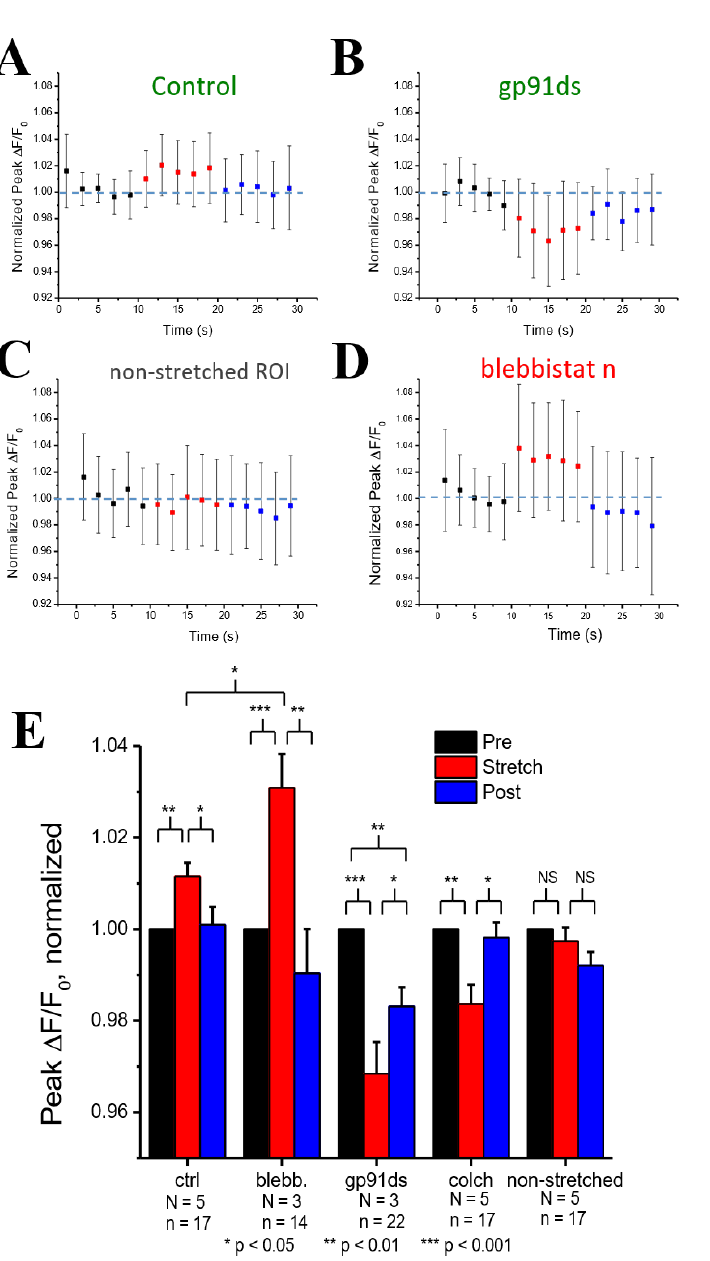
Figure 3. Experimental results for the normalized peak ∆ F/F0 for the concentration of Ca 2+ in the myoplasm ([Ca 2+ ] i ) with 0.5 Hz stimulus when the cardiomyocyte is at rest (black), stretched (red) and released after the stretch (blue) A . Under control condition. B . When blebbistatin is used which inhibits the actin – myosin bridge formation. C . When gp91ds is used which inhibits NOX2 from producing stretch-dependent ROS. D . In a non-stretched region of control myocytes, and E . the calculated average of peak ([Ca 2+ ] i ) under each subgroup (rest, stretched and released) of each group (control, blebbistatin, gp91ds, colchicine and non-stretched). N is the number of animals and n is the number of cells. Statistical comparisons were carried out using the paired t -test.